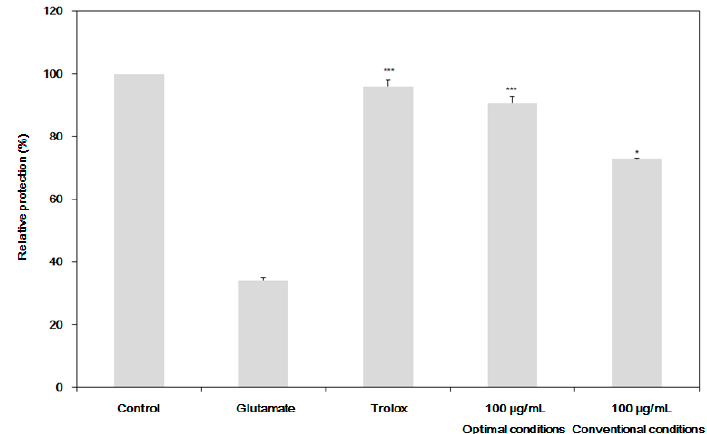
Figure 3. Comparison of the neuroprotective activities of the extracts from the optimal extraction process and a conventional 70% ethanol extraction process by the growth of the glutamate-induced mouse hippocampal neuronal cell line (HT22). * Significant at p < 0.05, *** Significant at p < 0.001.